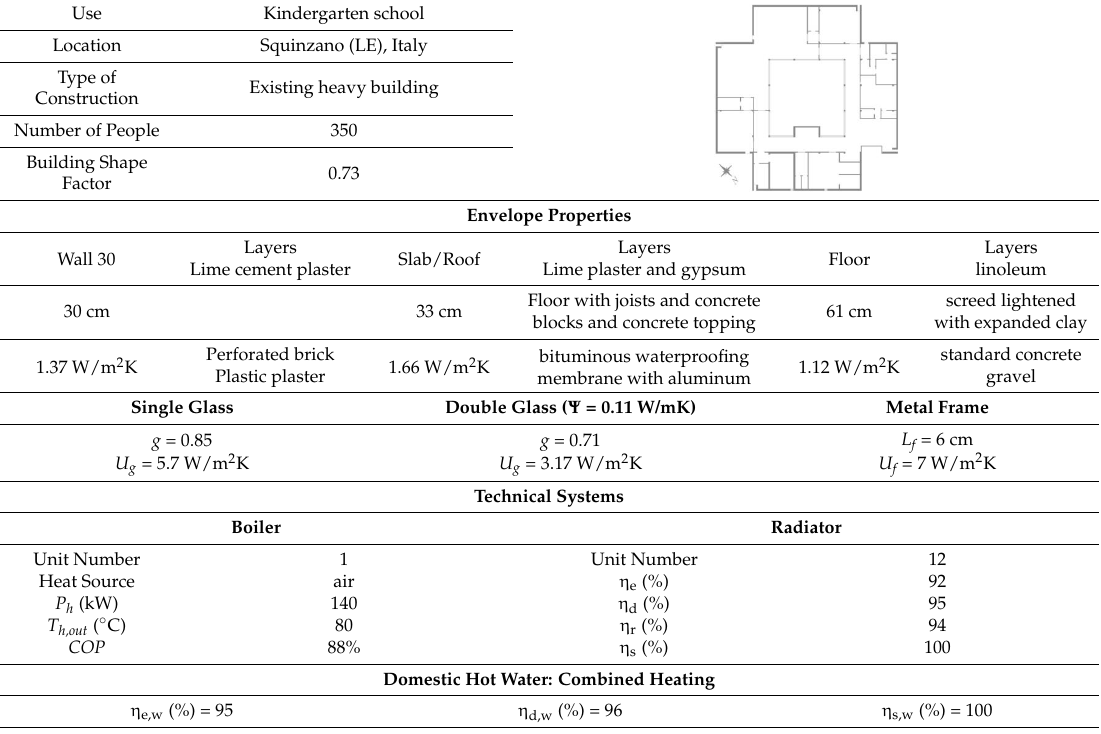
Table 3. Construction properties and element data set of the reference building in Squinzano (REF2). Use